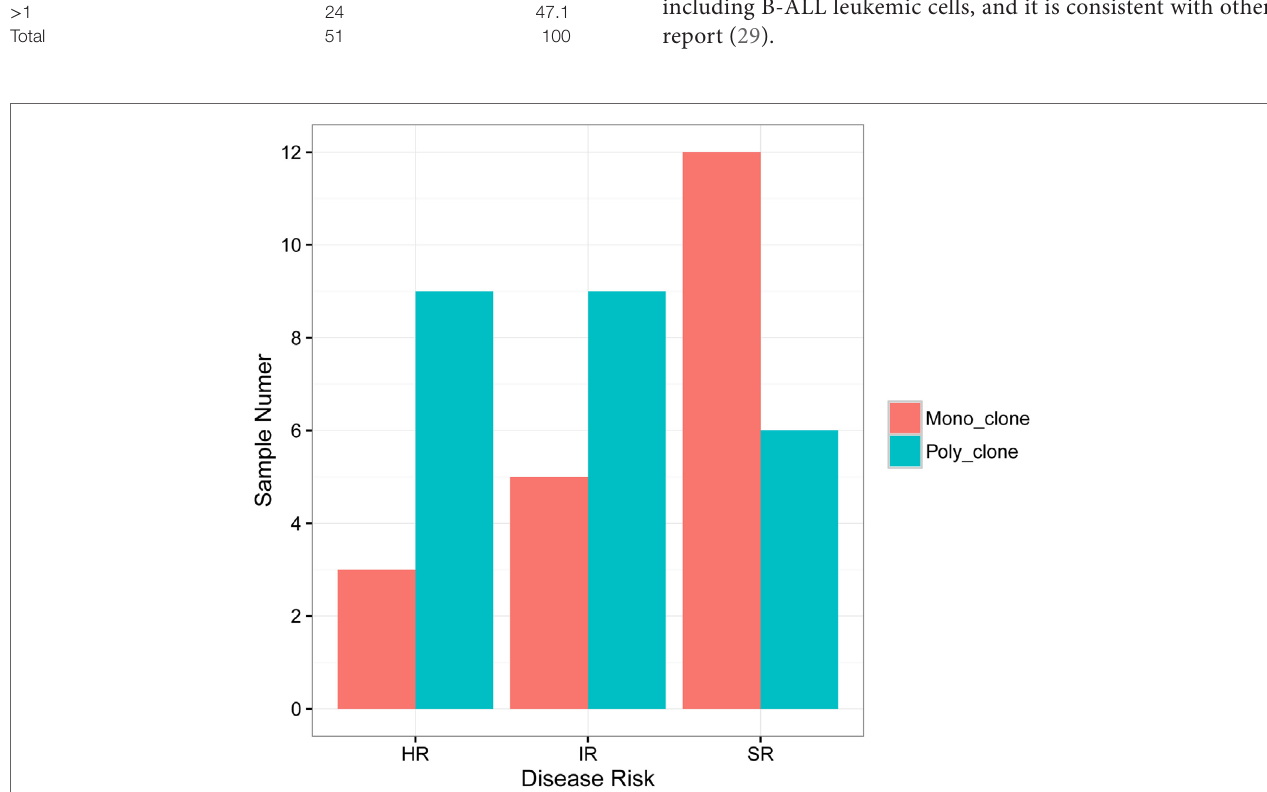
FigUre 1 | correlation of B-all disease risk with the number of leukemic clones in diagnostic sample . HR, high risk; IR, intermediate risk; SR, standard risk; “mono_clone,” just one leukemic clone in the diagnostic sample; “poly_clone,” two or more leukemic clones in the diagnostic sample.